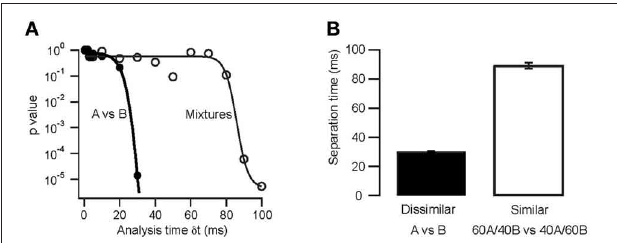
FIGURE 8 | Separation times for dissimilar and similar odor pairs in the model. (A) Stimulus separation ( p value of the comparison of reproducibility and similarity) as a function of analysis window time δ t . Thick lines are sigmoidal fits. (B) Separation times (time at which reproducibility was significantly higher than similarity) for dissimilar and similar odor pairs. Error bars indicate s.e.m. from 10 odor pairs (eight repetitions each as in A ).